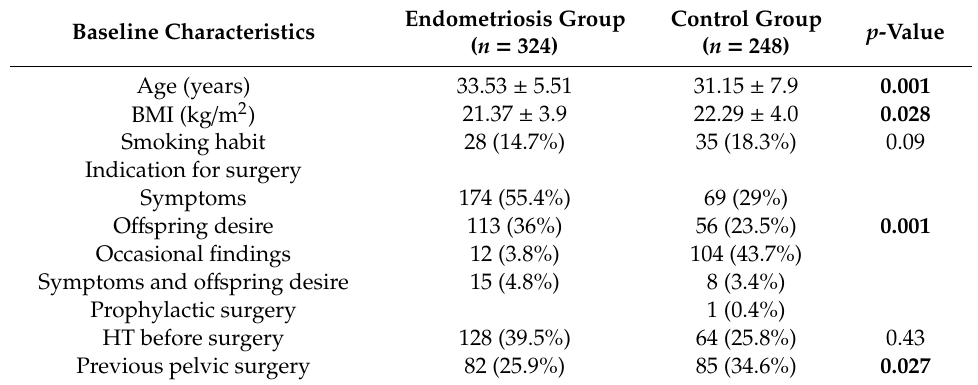
Table 1. Baseline characteristics of the endometriosis and control